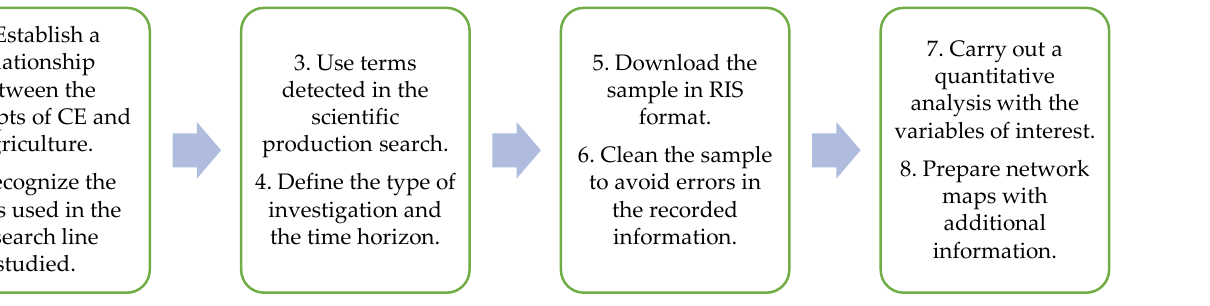
Figure 1. Graphic representation of the methodology used.